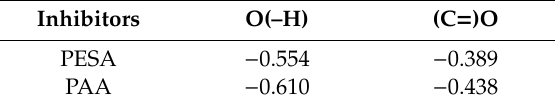
Figure 8. Optimal configurations of PESA. Table 2. Negative charge distribution of two